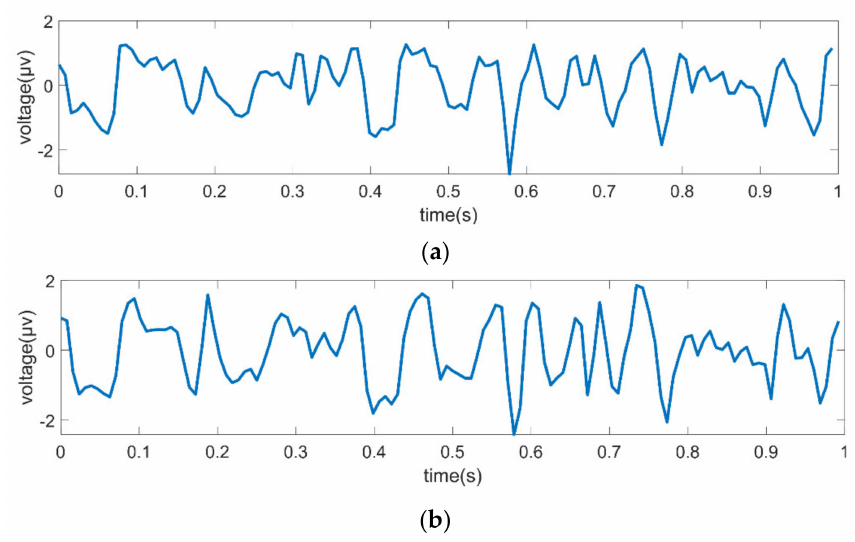
Figure 2. The EEG signal before baseline preprocessing ( a ) and after baseline preprocessing ( b ). Five people are selected from the DEAP dataset to investigate the impact of baseline preprocessing on emotion recognition performance. Both baseline-preprocessed and un- preprocessed EEG data are used for emotion identification, and the results on arousal and valence are depicted in Figure 3.